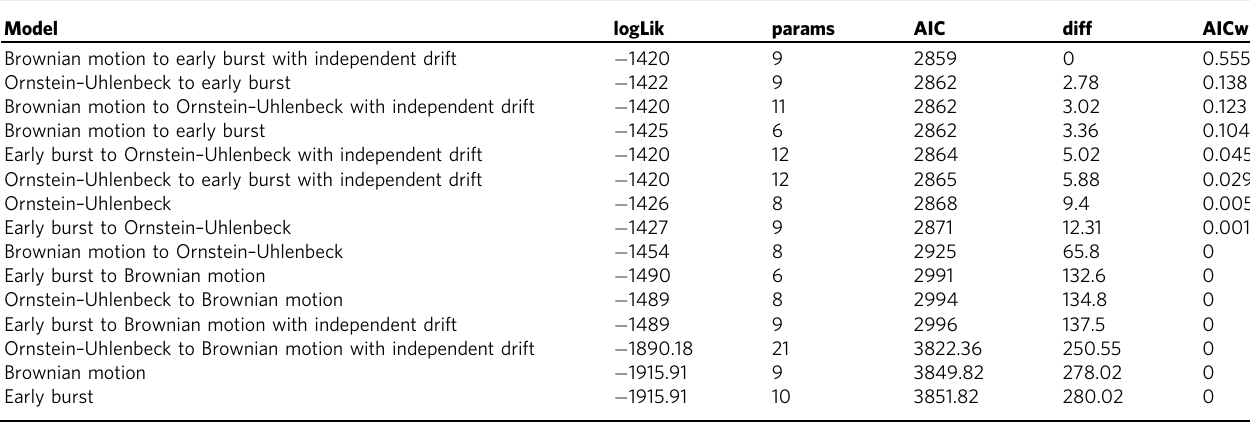
Table 2 Comparison of multivariate evolutionary models with or without shift, tested to identify the morphological diversi fi cation pattern of the radiation of Niphargus .